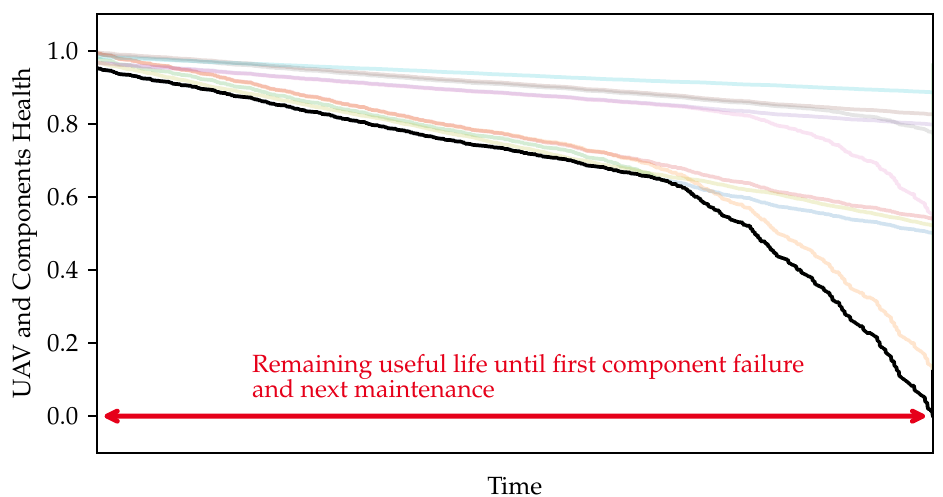
Figure 6. Fault constellation of one UAV with its subsystems. The diagram shows the degradation of the UAV over time. To avoid confusion between simulation time and actual time, the exact indication of the time unit on the x-axis has been removed. Black represents the system state derived from the most degraded